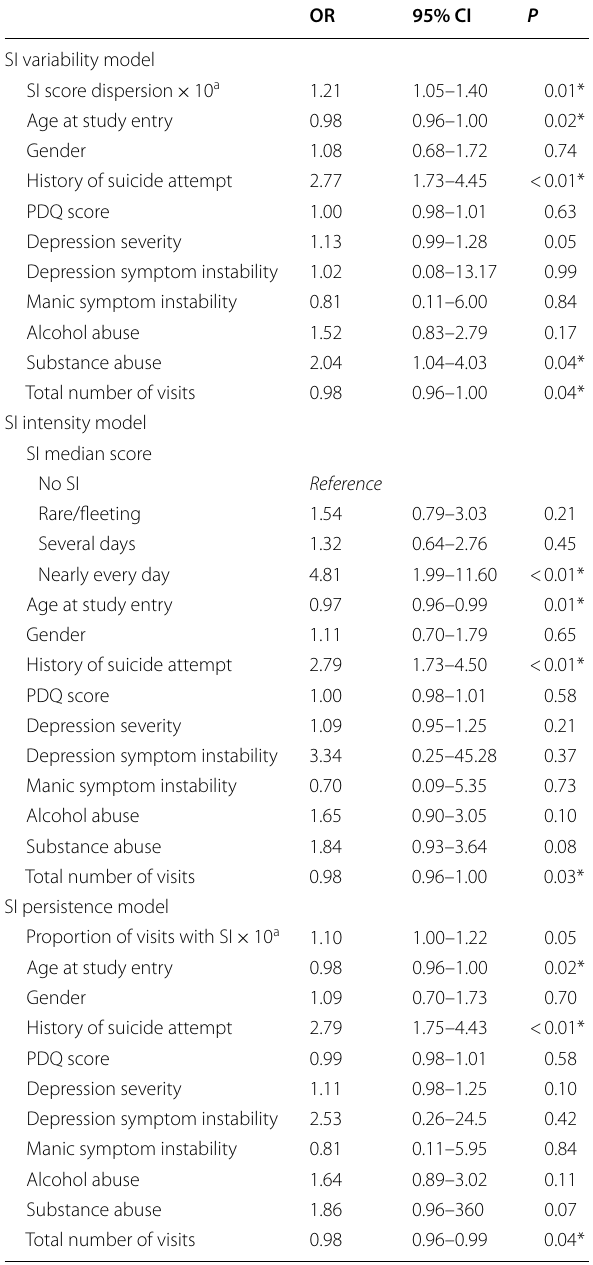
Table 3 Odds ratios for predictors of prospective